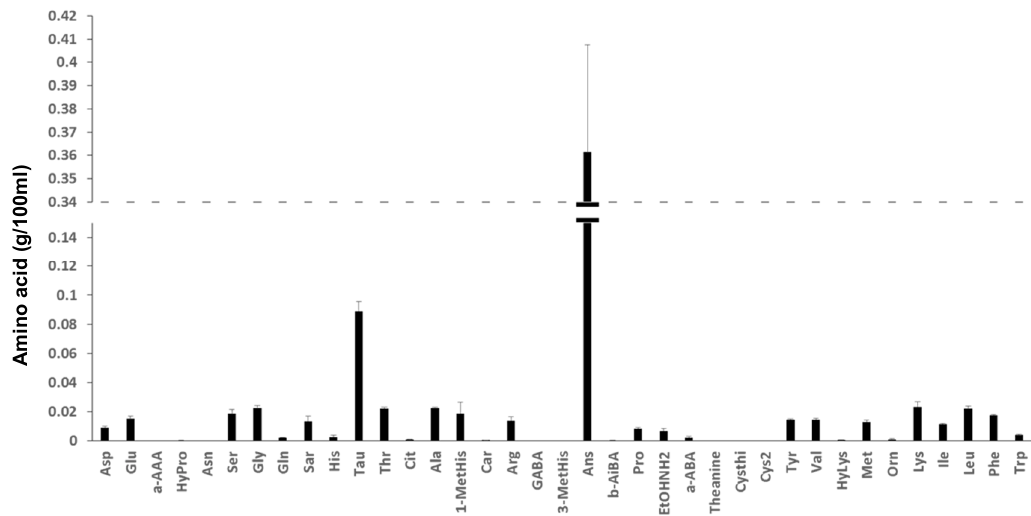
Figure 11. Amino acid compositions of the GMSFS. Values represent mean ± standard deviation ( n = 3). Asp, aspartic acid; Glu, glutamic acid; α -AAA, α -Aminoadipic acid; Hypro, hydroxyproline; Asn, asparagine; Ser, serine; Gly, glycine; Gln, glutamine; Sar, sarcosine; His, histidine; Tau, taurine;